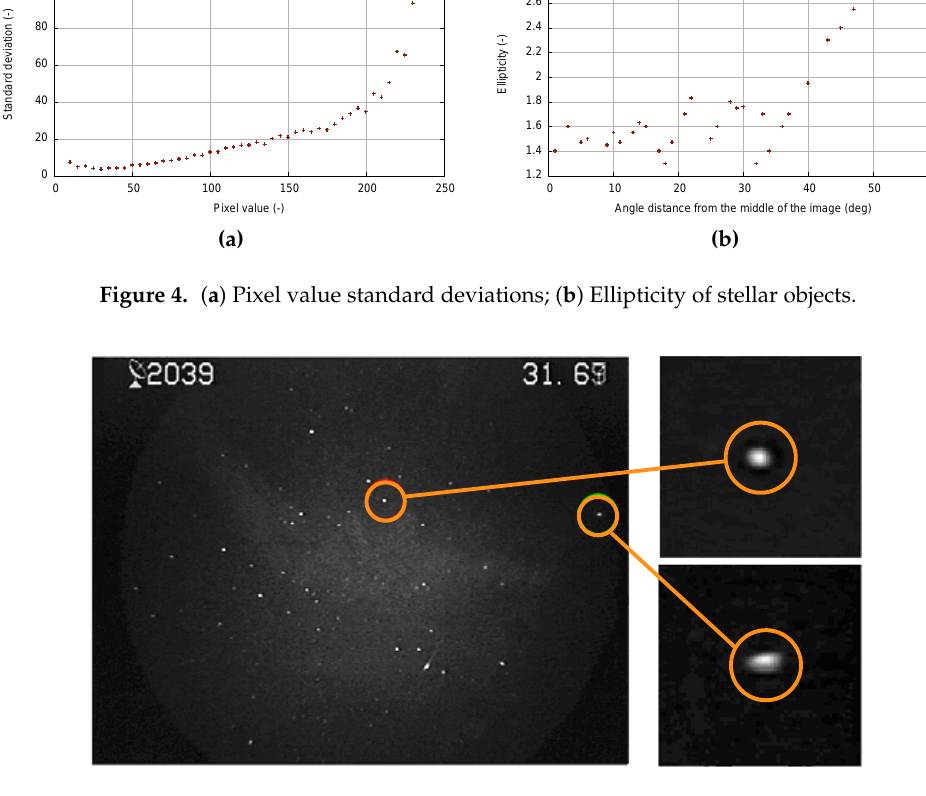
Figure 5. Shift-variant point spread function of the MAIA electro-optical